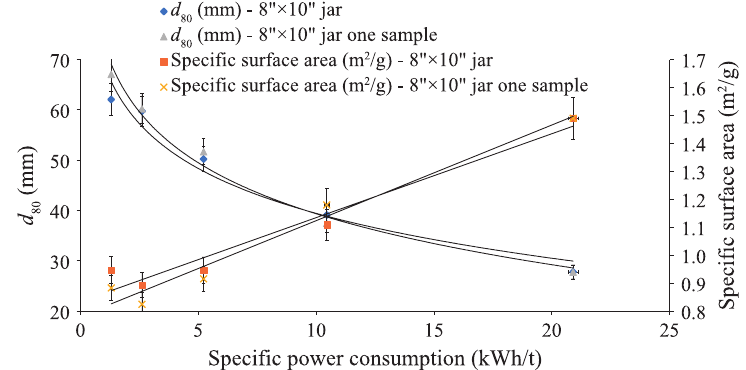
Fig. 10 Specific power consumption as a function of d 80 and specific surface area—one sample per